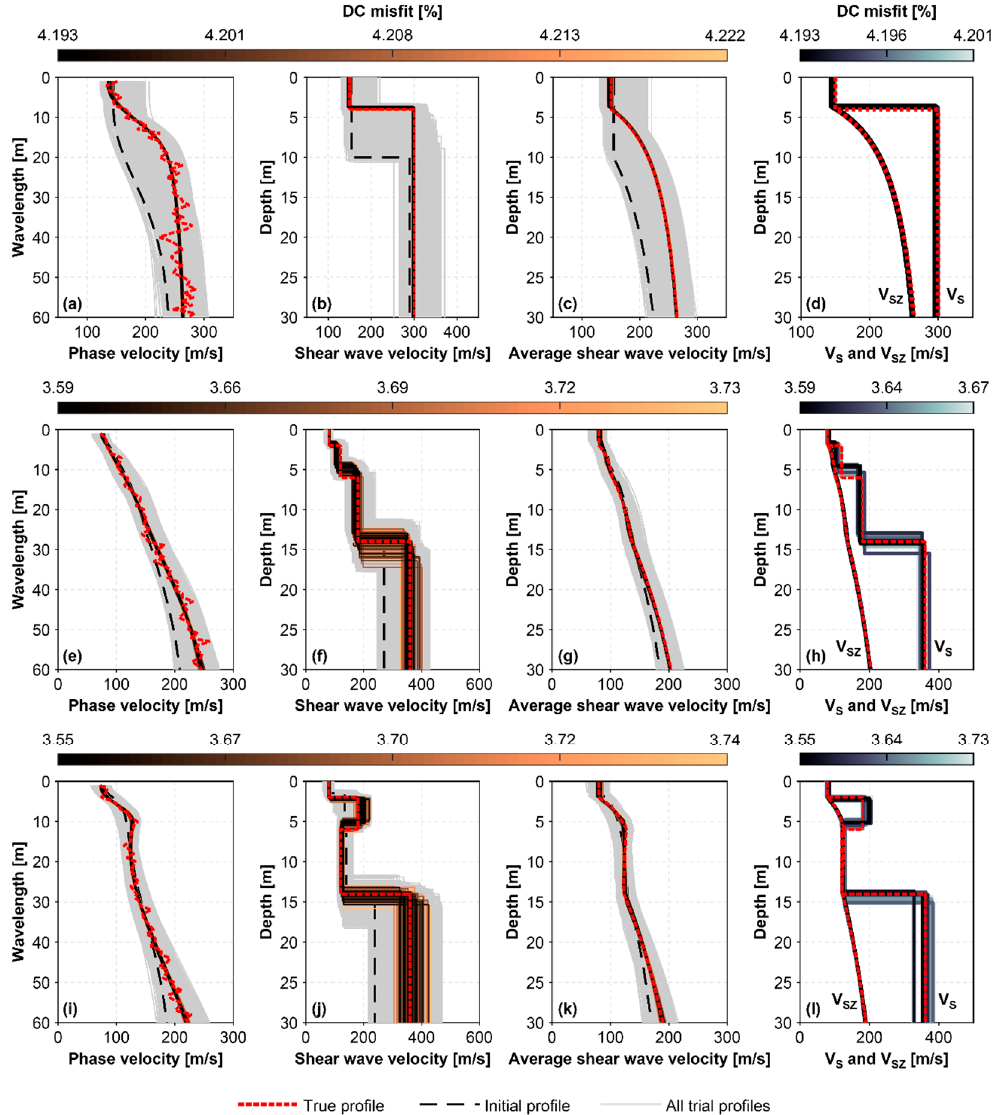
Figure 17. Inversion of synthetic dispersion curves for ( a – d ) model A, ( e – h ) model B and ( i – l ) model C. The target dispersion curves have been perturbed by introduction of a 5% white Gaussian noise. A two-layer geologic structure was assumed for inversion of the data from model A. A geologic structure consisting of four layers was assumed for models B and C.